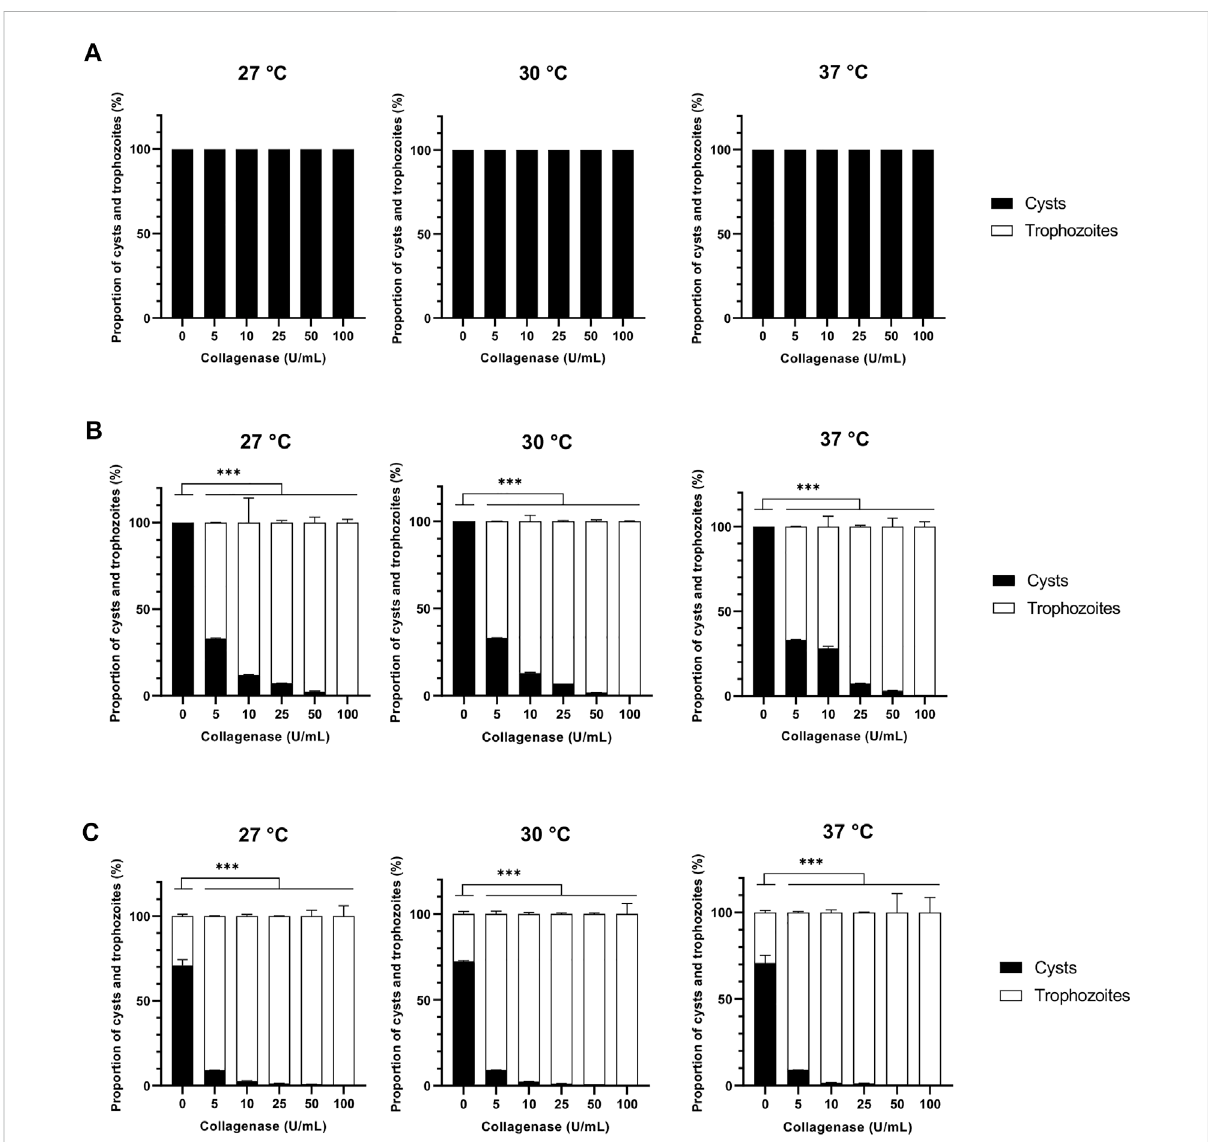
FIGURE 2 Effectofcollagenaseon Acanthamoebacastellanii excystment.Proportionsof A.castellanii trophozoitesandcystsobservedfollowing24 h (A) , 48 h (B) and 72 h (C) ofcollagenase treatment at27, 30and 37 ° C as afunctionof enzyme concentration. The results correspond to themean of four independent experiments